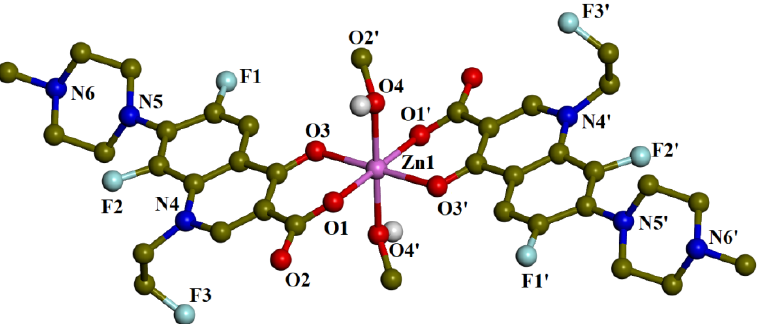
Figure 2. A drawing of the molecular structure of 3 with only the heteroatom labeling. Aromatic and methanol hydrogen atoms are omitted for clarity. Table 1. Selected bond distances and angles for complex 3 .